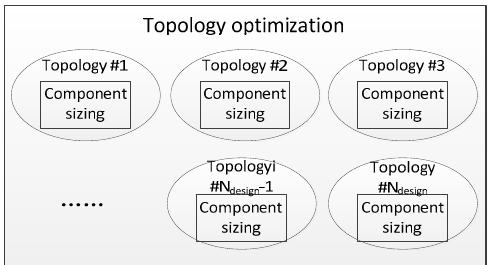
Figure 6. Schematic diagram of the nested optimization.